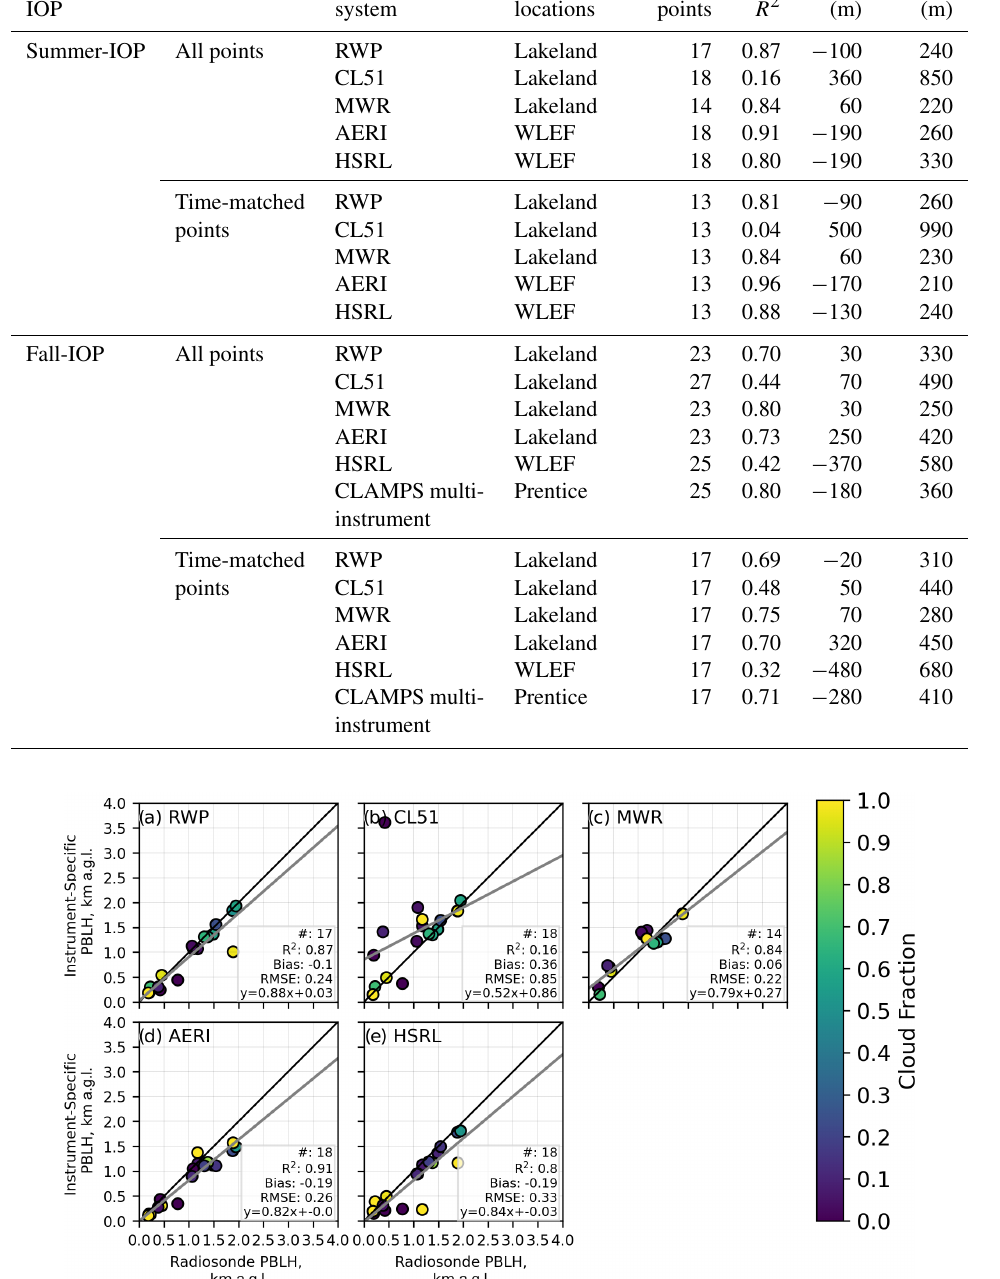
Figure 12. Comparison of the PBLHs by the parcel method applied to the radiosonde virtual potential temperature profiles ( x axis) versus those ( y axis) estimated (a) by the RWP fuzzy-logic method, (b) the CL51 QC-scaled approach, the parcel method applied to the (c) MWR and (d) AERI virtual potential temperature profiles, and (e) the expert opinion to the HSRL observations, for the Summer-IOP period. The color coding shows the site-respective cloud fraction values. Black lines represent the 1-to-1 line, and grey lines represent the best-fit